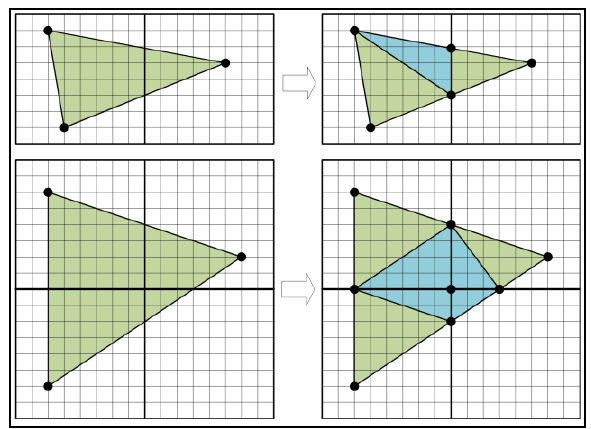
Figure 4. An overhead view of the triangulating process